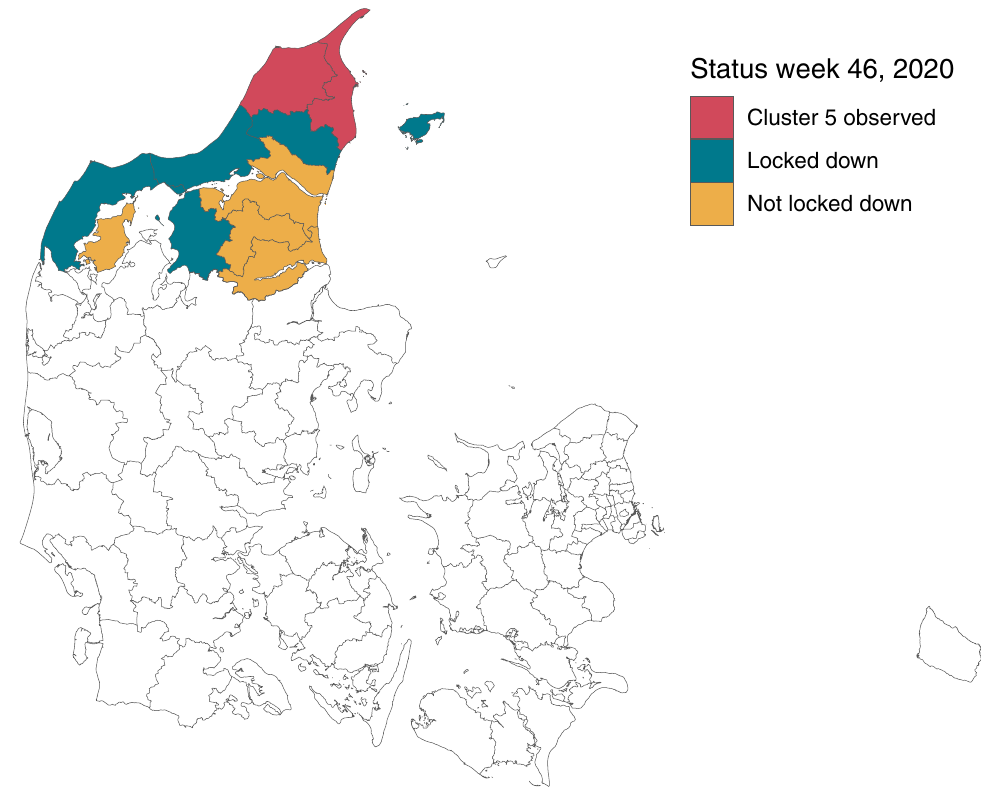
Figure 3. Status for the municipalities in the North Denmark Region following the lock-down order on November 6, 2020. The order was imposed in municipalities with observations of Cluster-5 (red), as well as surrounding municipalities with a high concentration of mink farms (blue). The remaining coloured municipalities belong to the North Denmark Region, but was not locked down. The remaining municipalities in Denmark are coloured white.